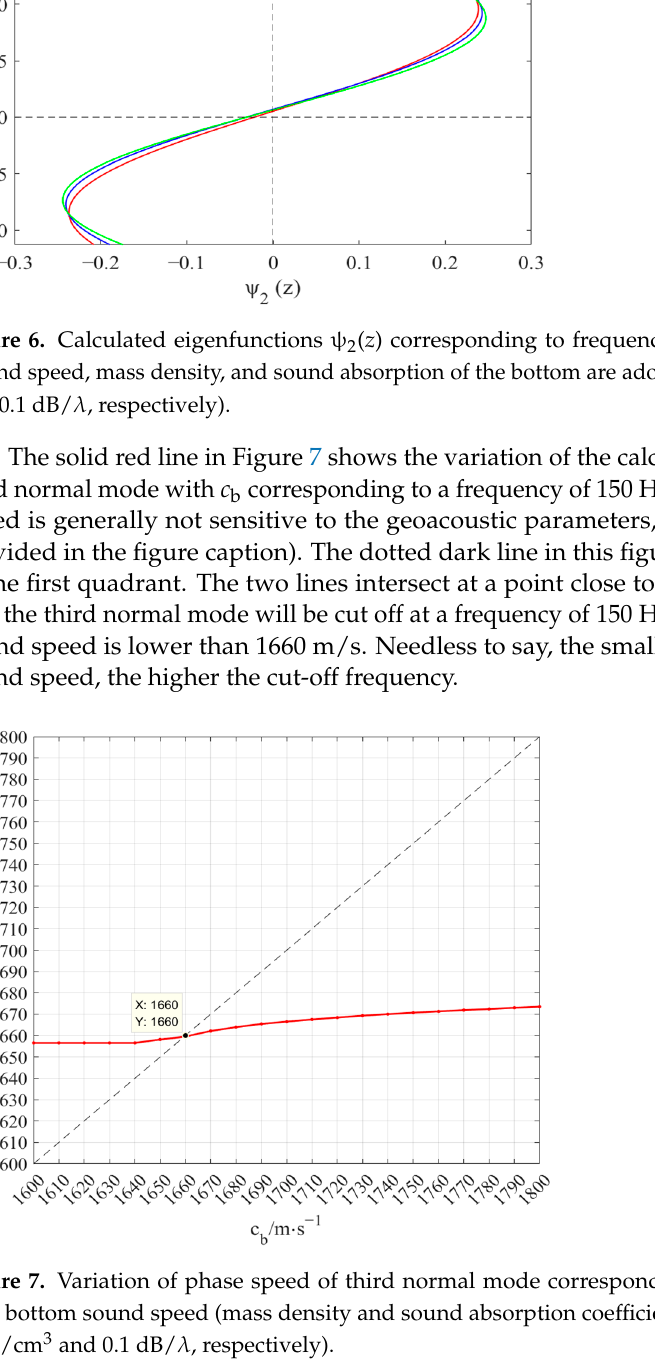
Figure 7. Variation of phase speed of third normal mode corresponding to frequency of 150 Hz with bottom sound speed (mass density and sound absorption coefficient of bottom are adopted as 1.8 g/cm 3 and 0.1 dB/ λ , respectively).